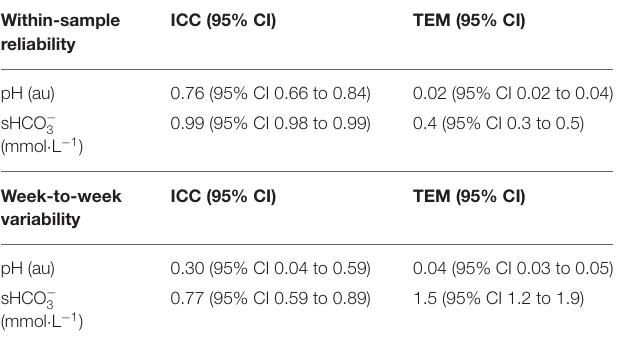
TABLE 1 | Mean ± SD macronutrient profile [carbohydrate (CHO), protein, fat], fiber and total energy (TE) during the 24h prior to the trials and the Pre-TT snack for both IT and CON.